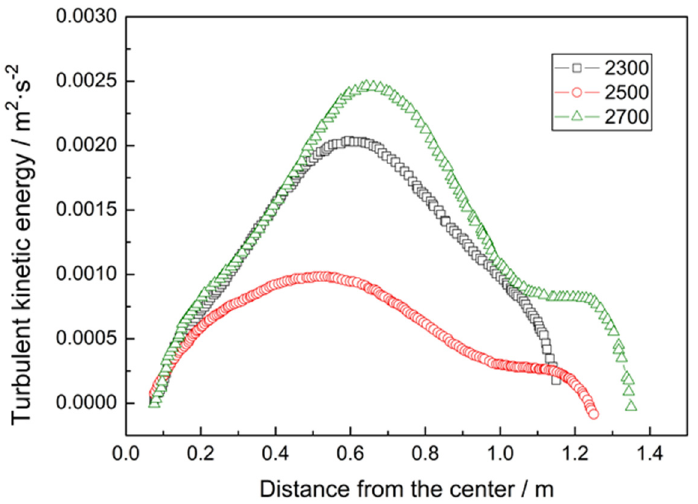
Figure 15. Influence of slab width on the turbulent kinetic energy at the free surface.